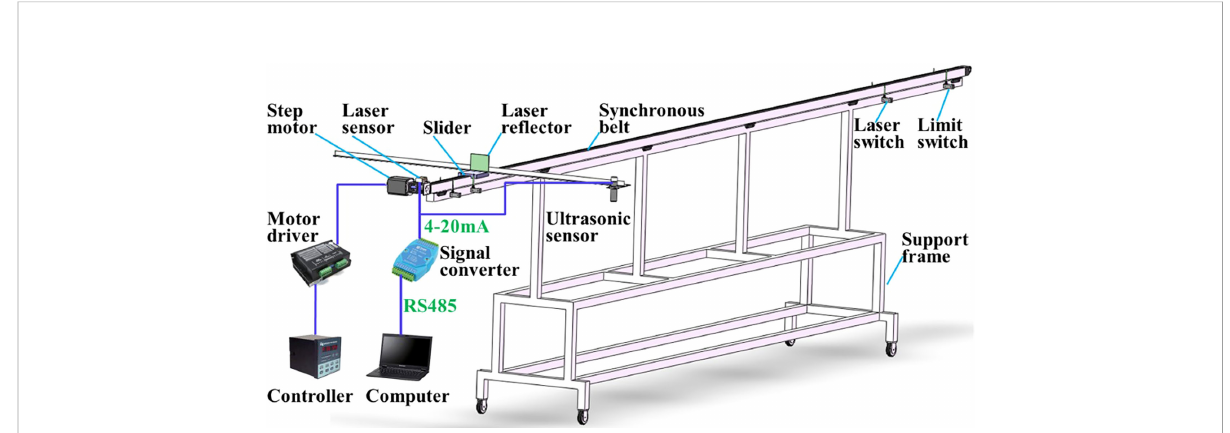
FIGURE 3 Structural diagram of boom height probing platform based on laser/ultrasonic sensor. The designed effective length of sliding platform track is 6.0 m, which can realize the test under different speed conditions.